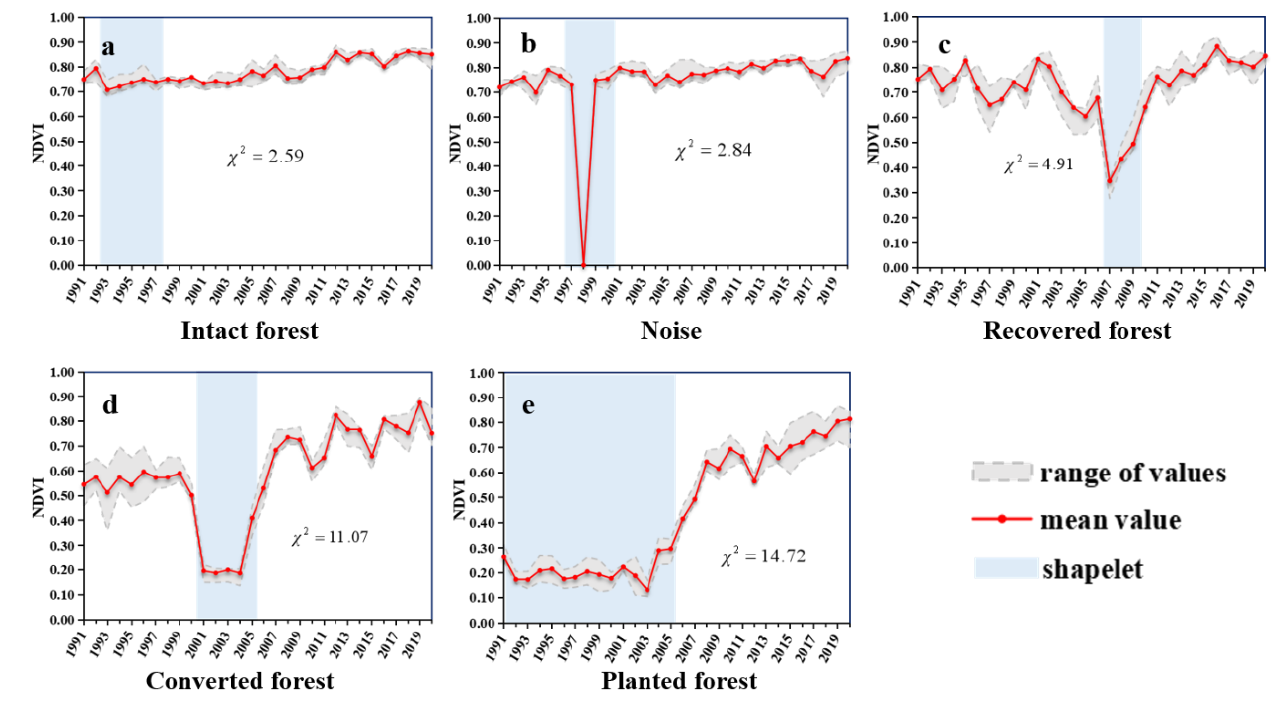
Figure 5. Five typical cases of NDVI trajectory patterns of forest objects: ( a ) intact natural forest; ( b ) clouds and cloud-shadow noise; ( c ) recovered natural forest; ( d ) planted forest converted from cropland; and ( e ) planted forest established on bare land. Notes: For each case, the time series (red broken line) is stacked via the object-level NDVI mean values, whereas the range of values for the homogenous pixels is represented by the shadow area. The shapelet is composed of the time nodes covered by the blue area, and a statistic χ 2 calculated using the m-test explains the significance of the difference between the shapelet and non-shapelet.